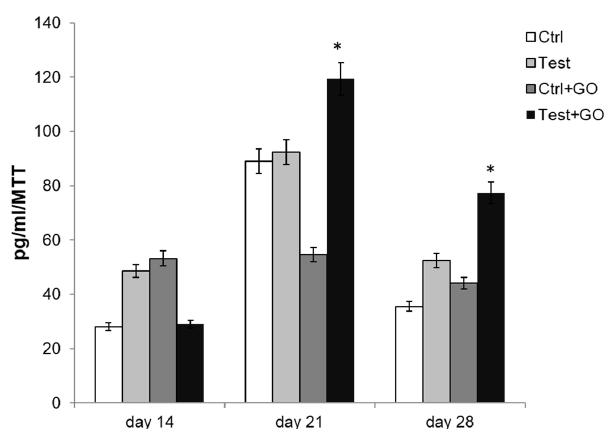
Figure 10. ELISA assay for PGE2 secretion of DPSCs cultured on Ti discs for 14, 21, and 28 days. Secretion levels are reported as picograms per milliliter per MTT optical density (OD) values. The results are the mean ± SD of three samples from three different experiments. * Day 21 and day 28: test + GO vs. control, test, control + GO p < 0.05.